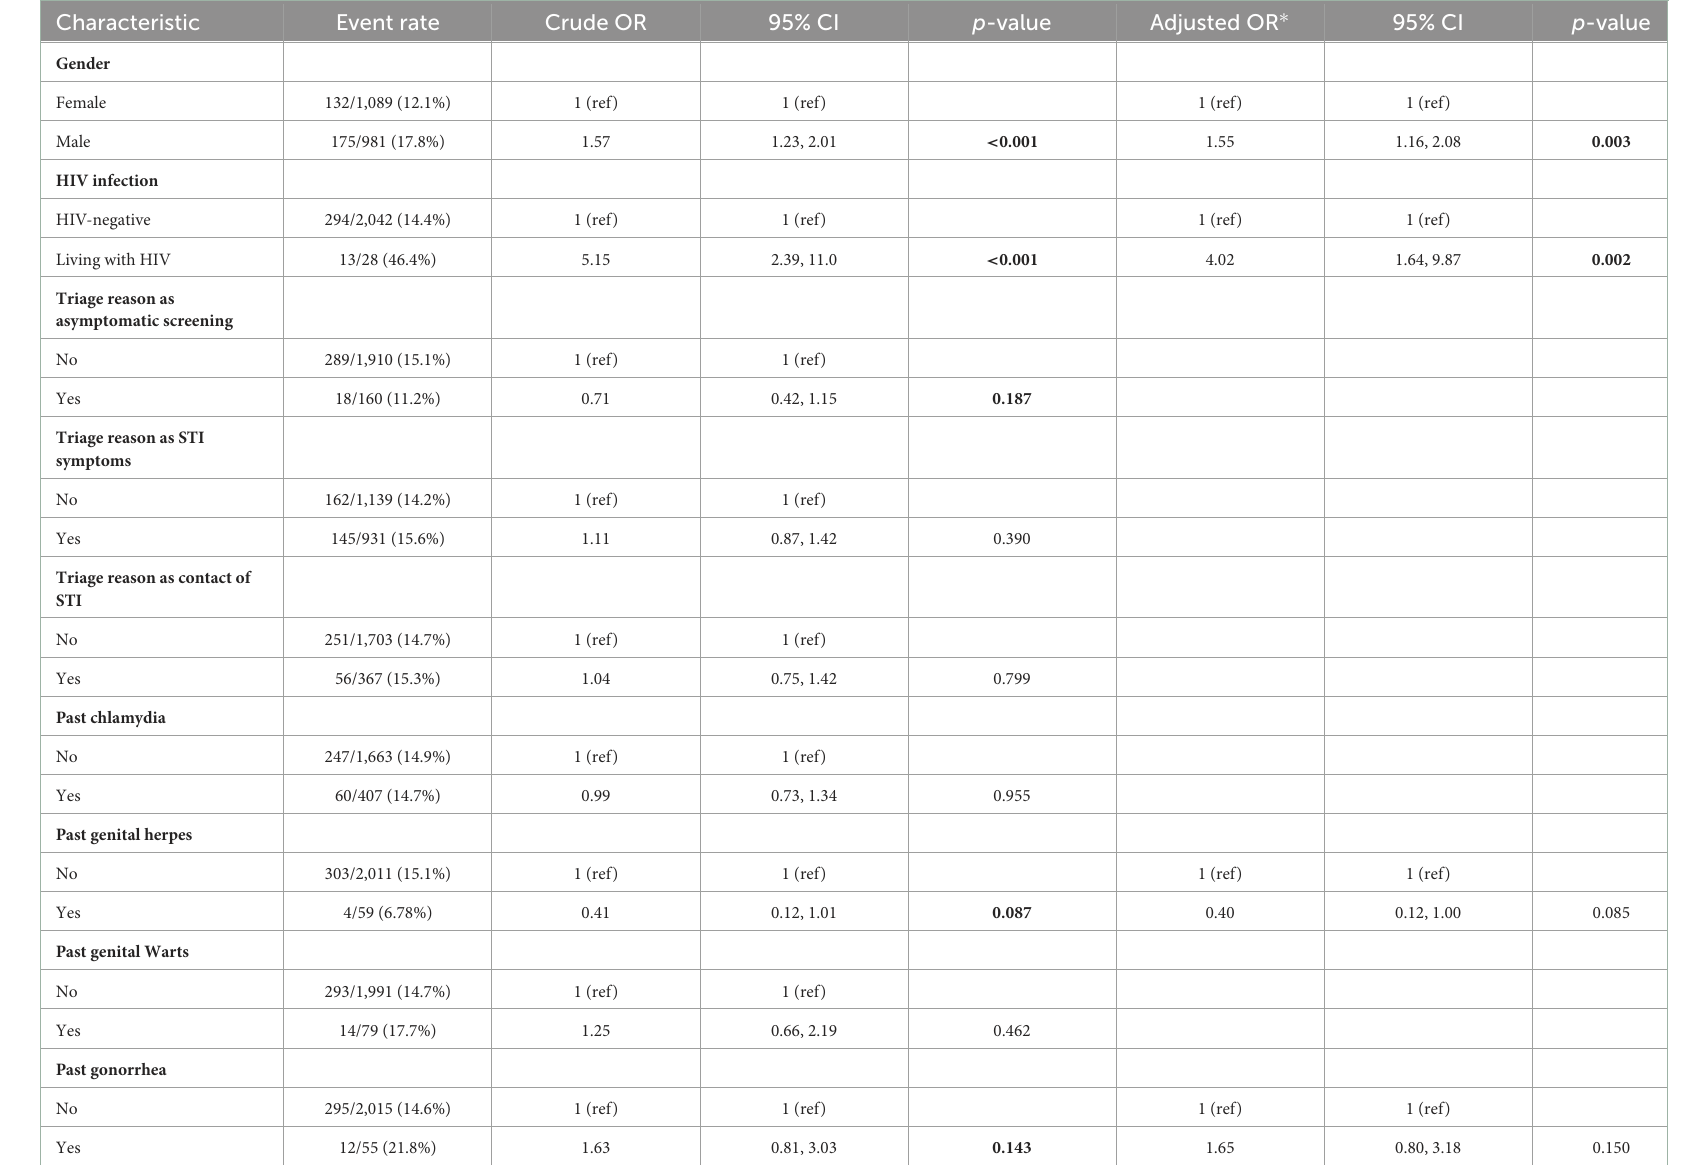
TABLE 2 Factors associated with chlamydia re-infection within 1 year among 2,070 re-tested heterosexual individuals. Characteristic Event rate Crude OR 95% CI p -value Adjusted OR ∗ 95% CI p